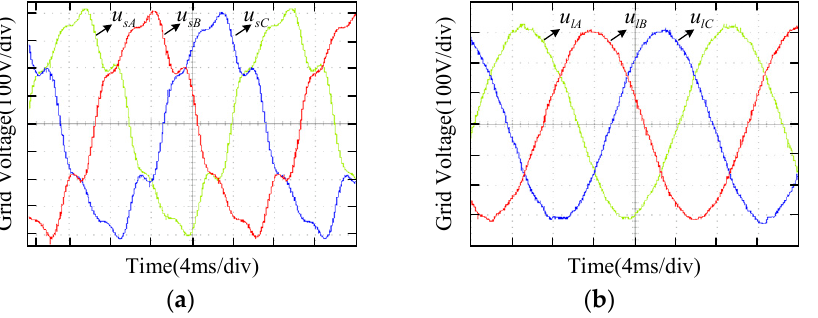
Figure 15. Temporary swell and harmonic conditions. ( a ) Grid voltage before compensation; ( b ) load voltage after compensation.